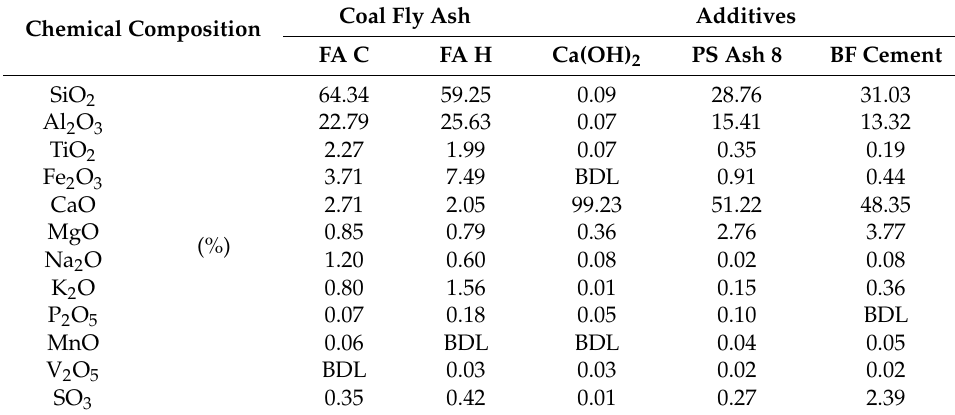
Table 1. Chemical composition of coal fly ash and